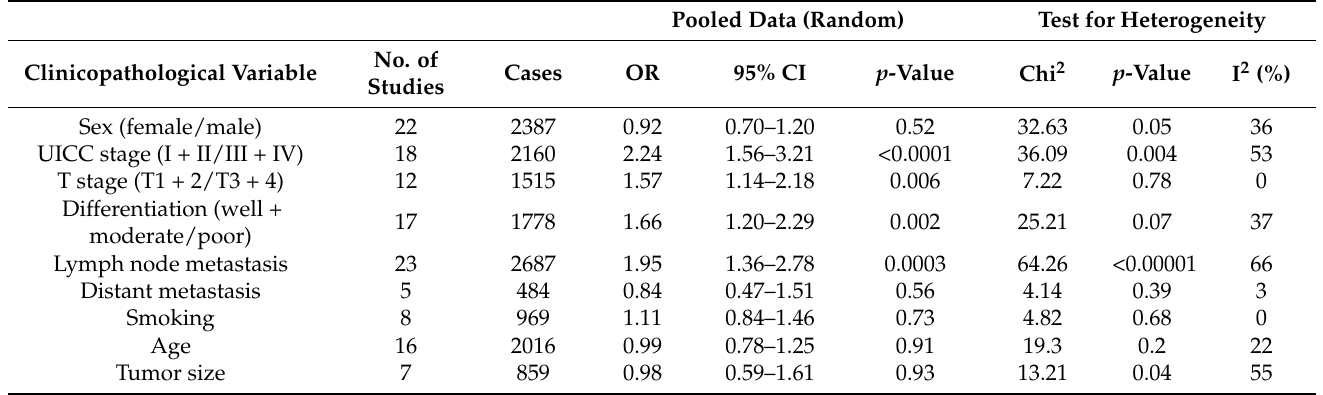
Table 4. Association between survivin/BIRC5 and clinicopathological variables. Pooled Data (Random) Test for